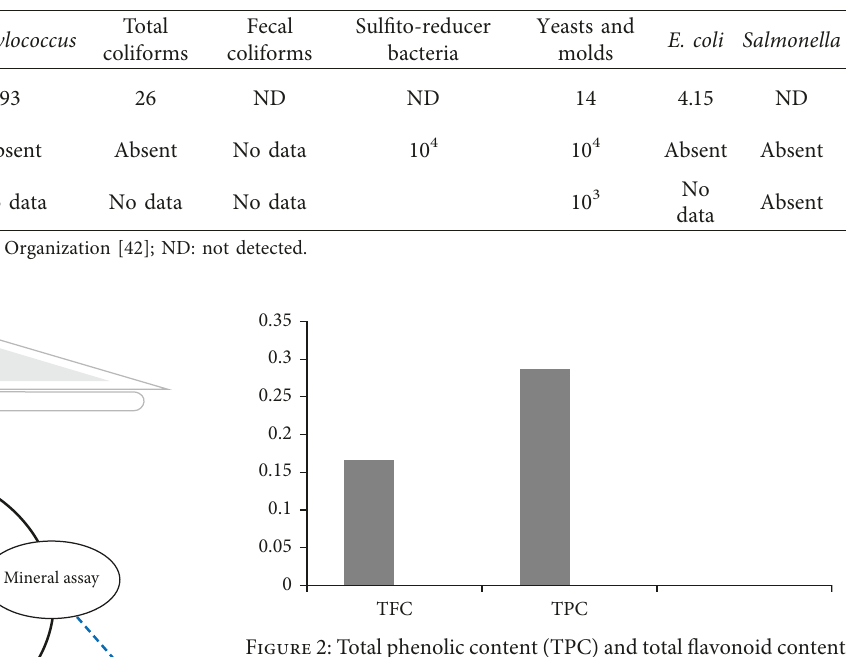
Table 3: Microbiological quality of edible Spirulina